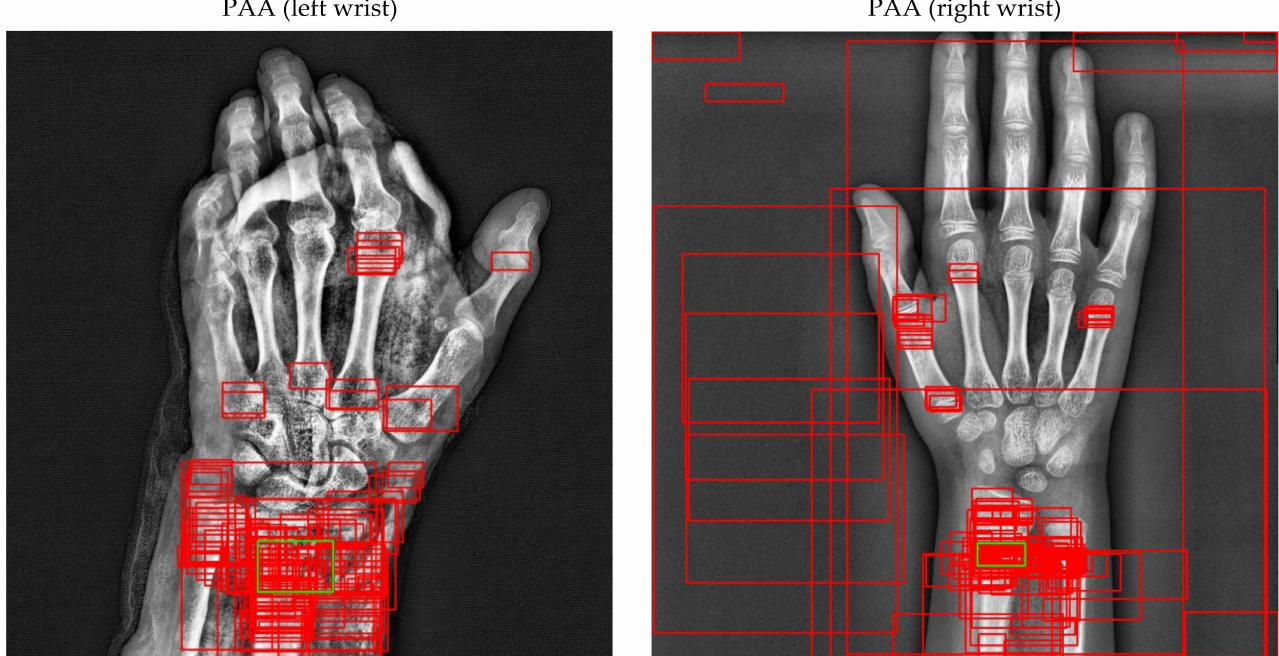
Figure 17. Sample of left/right wrist fracture results [ground-truth bounding box (green), predicted bounding box (red)] for PAA (Best score of 20